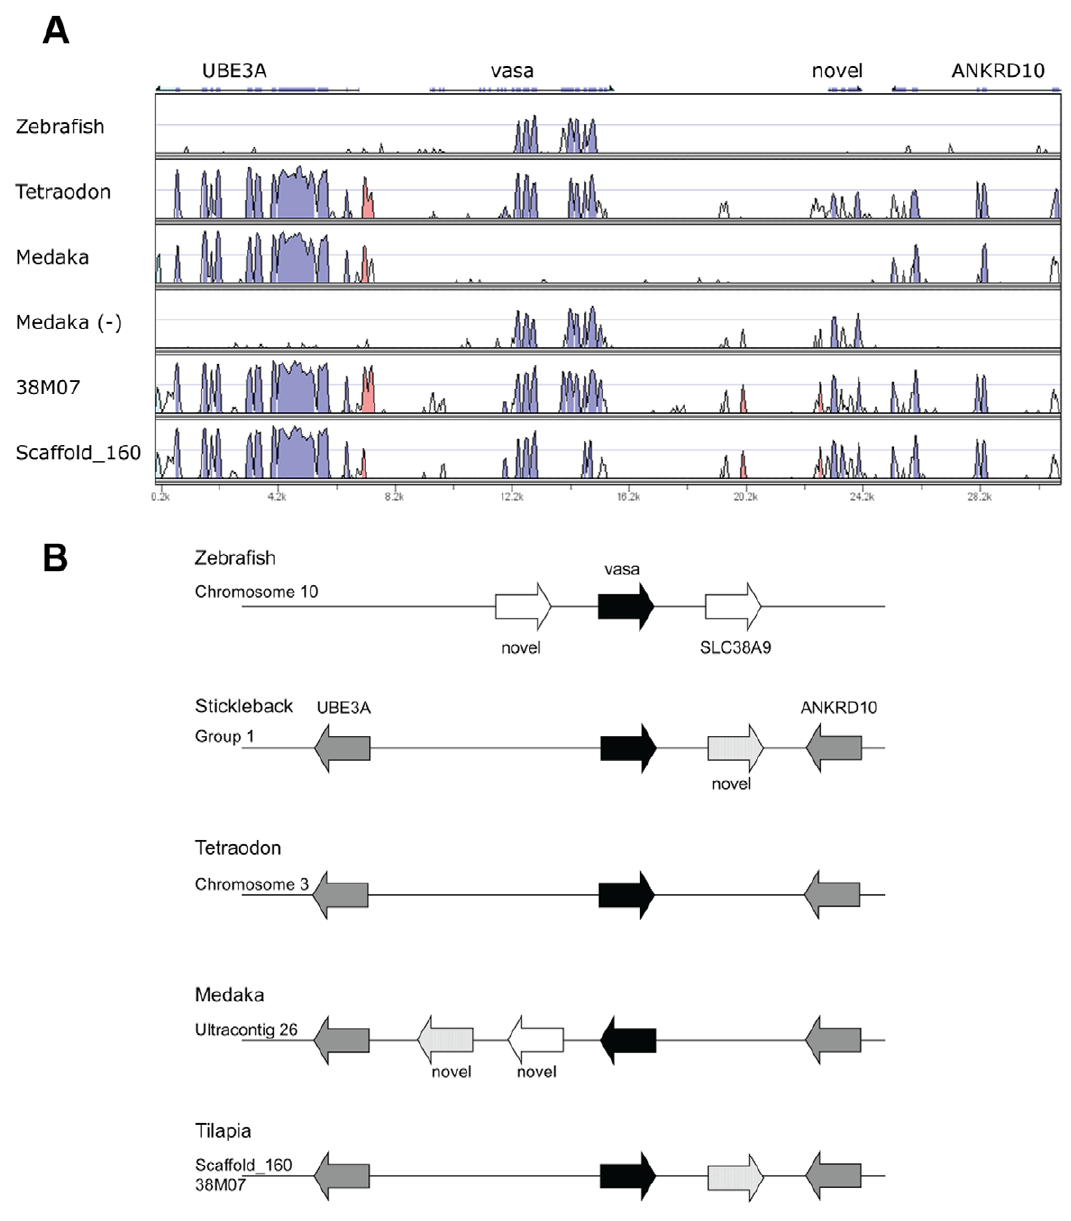
Figure 2. BAC clone 38M07 corresponds to a region between the UBE3A and ANKRD10 genes. (A) VISTA plots against stickleback show that 38M07 and Scaffold_160 cover a region between UBE3A and ANKRD10 genes, in which the vasa gene is located in other teleosts. The complementary sequence of medaka (-) was also used because of a local inversion of vasa in the genome assembly. (B) Genomic organization around the vasa gene of zebrafish, stickleback, Tetraodon , medaka and tilapia. The genomic organization is conserved in other teleosts except for the distantly related zebrafish, the inversion in medaka, and some lineage-specific predicted novel genes.